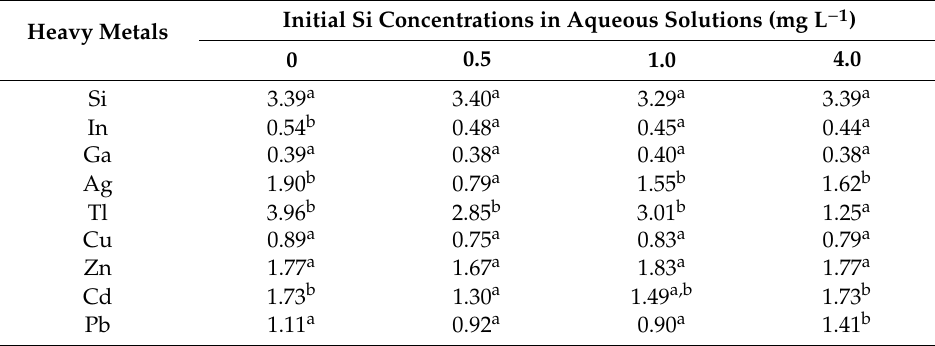
Table 2. The shoot / root ratios of E. acicularis after 21 d of the experiment Heavy Metals